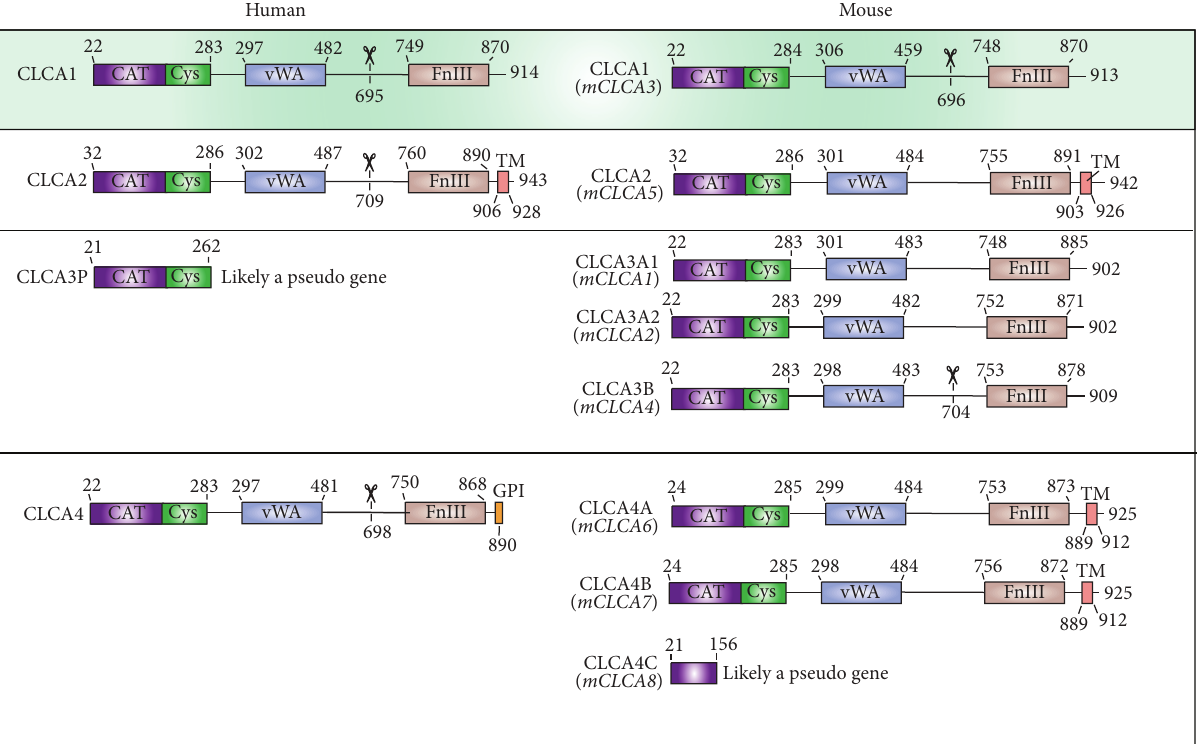
Figure 1: Domain architecture schematic for human and mouse CLCA proteins. Each row contains the corresponding human and mouse homologs. Mouse CLCA proteins are labeled according to the recently updated naming commissioned by the Mouse Gene Nomenclature Committee (MGNC) in order to align the numbering established by the Human Gene Nomenclature Committee and the Rat Genome